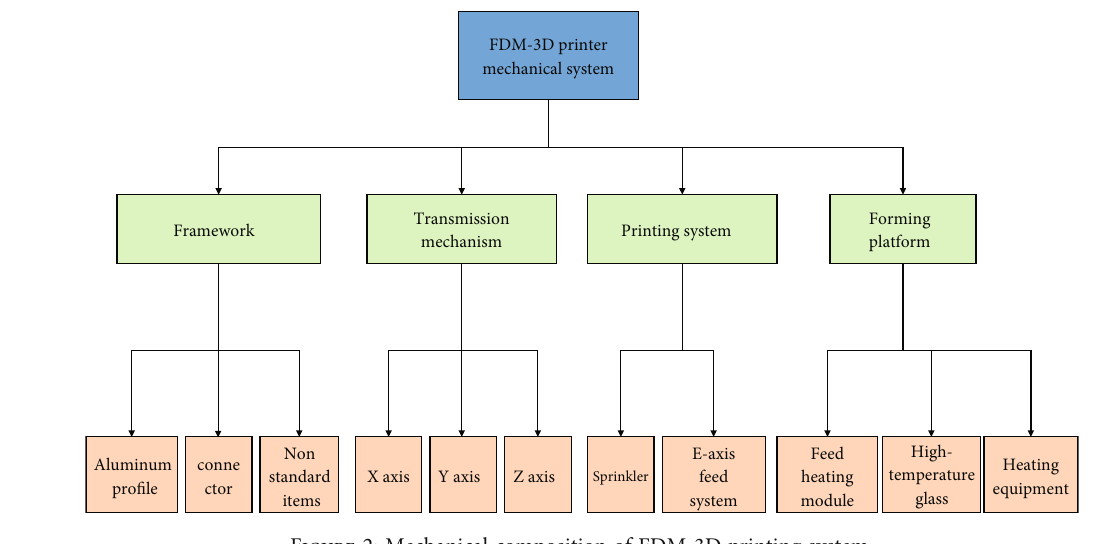
Figure 2: Mechanical composition of FDM-3D printing system.